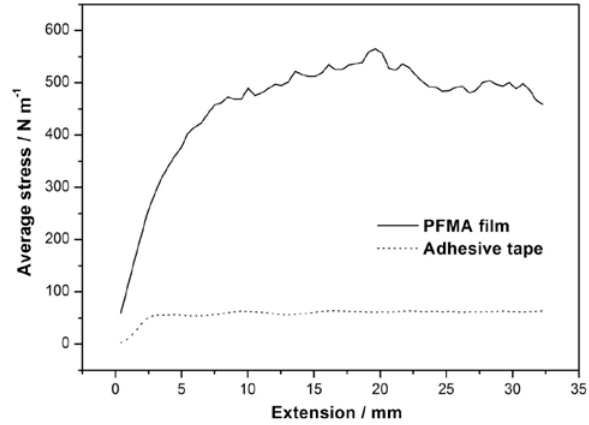
Figure 9. Stretch curves of the common adhesive tape (scotch tape) and the PFMA film with the thickness of 3.65 mm on the surface of indium tin oxide (ITO) glass substrate.